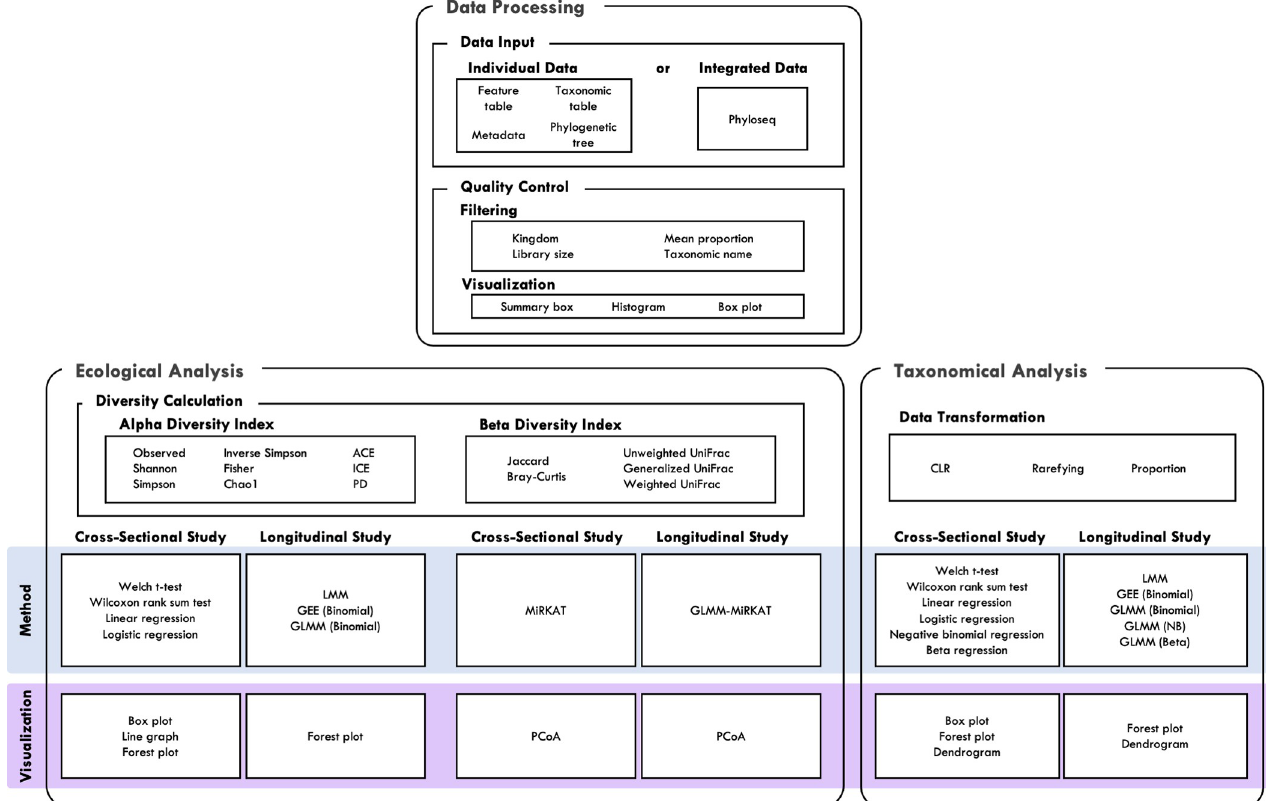
Fig 1. Overview of MiCloud. MiCloud consists of three main components, Data Processing , Ecological Analysis and Taxonomical Analysis and many sub- components.